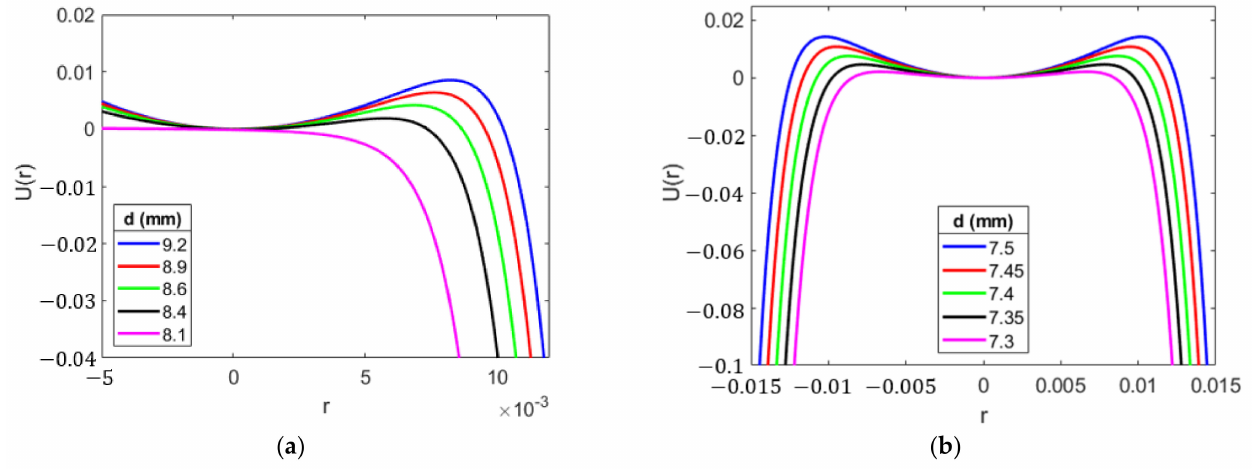
Figure 8. Potential energy for the attractive configurations with ( a ) single magnet and ( b ) double